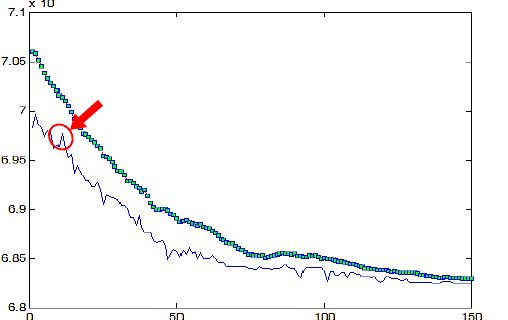
Fig. 9. A sample of escaping from local optimum traps by using local optimum escaping operator Stopping